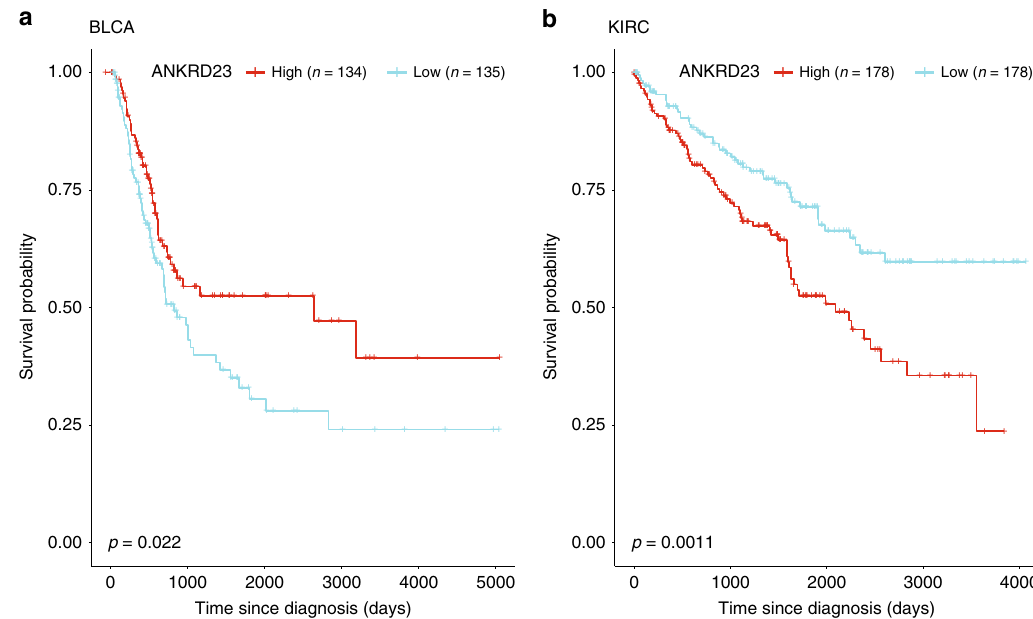
Fig. 5 Moonlight dual-role genes that could differentially in fl uence prognosis by cancer type or subtype. Clinical implication ( a , b ) Kaplan – Meier survival curves show that ANKRD23 is a tumor suppressor in BLCA ( a ) and an oncogene in KIRC ( b